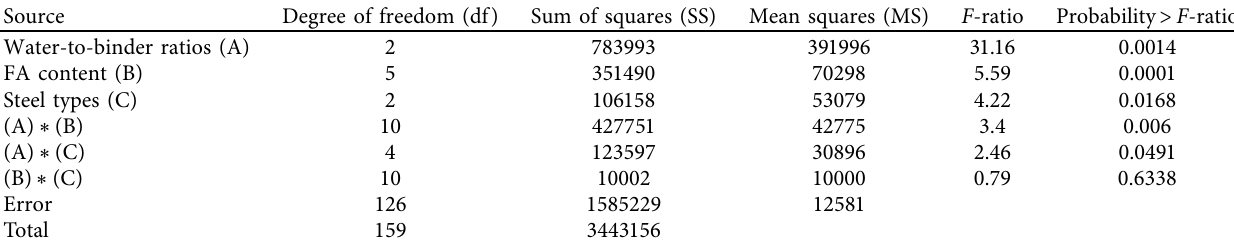
Table 7: ANOVA result for passive to transpassive potential for uncarbonated concrete.